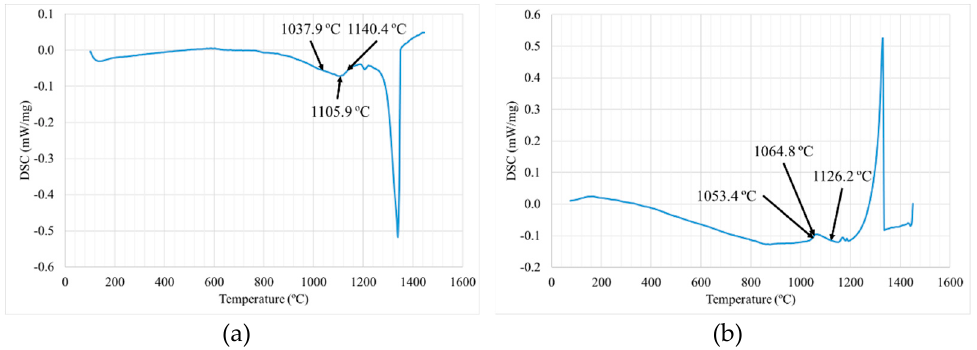
Figure 7. DSC of Astroloy B1 powder for ( a ) heating and ( b ) cooling.